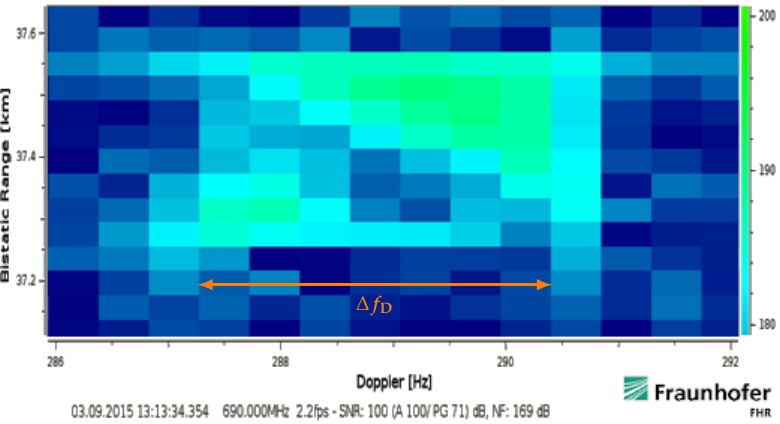
Figure 11. Fluctuating approaching target return moving with a constant v ≈ 225km/h and inte- grated in B eff = 7.61MHz over T int = 1.79s during a coherent processing interval of T cov =